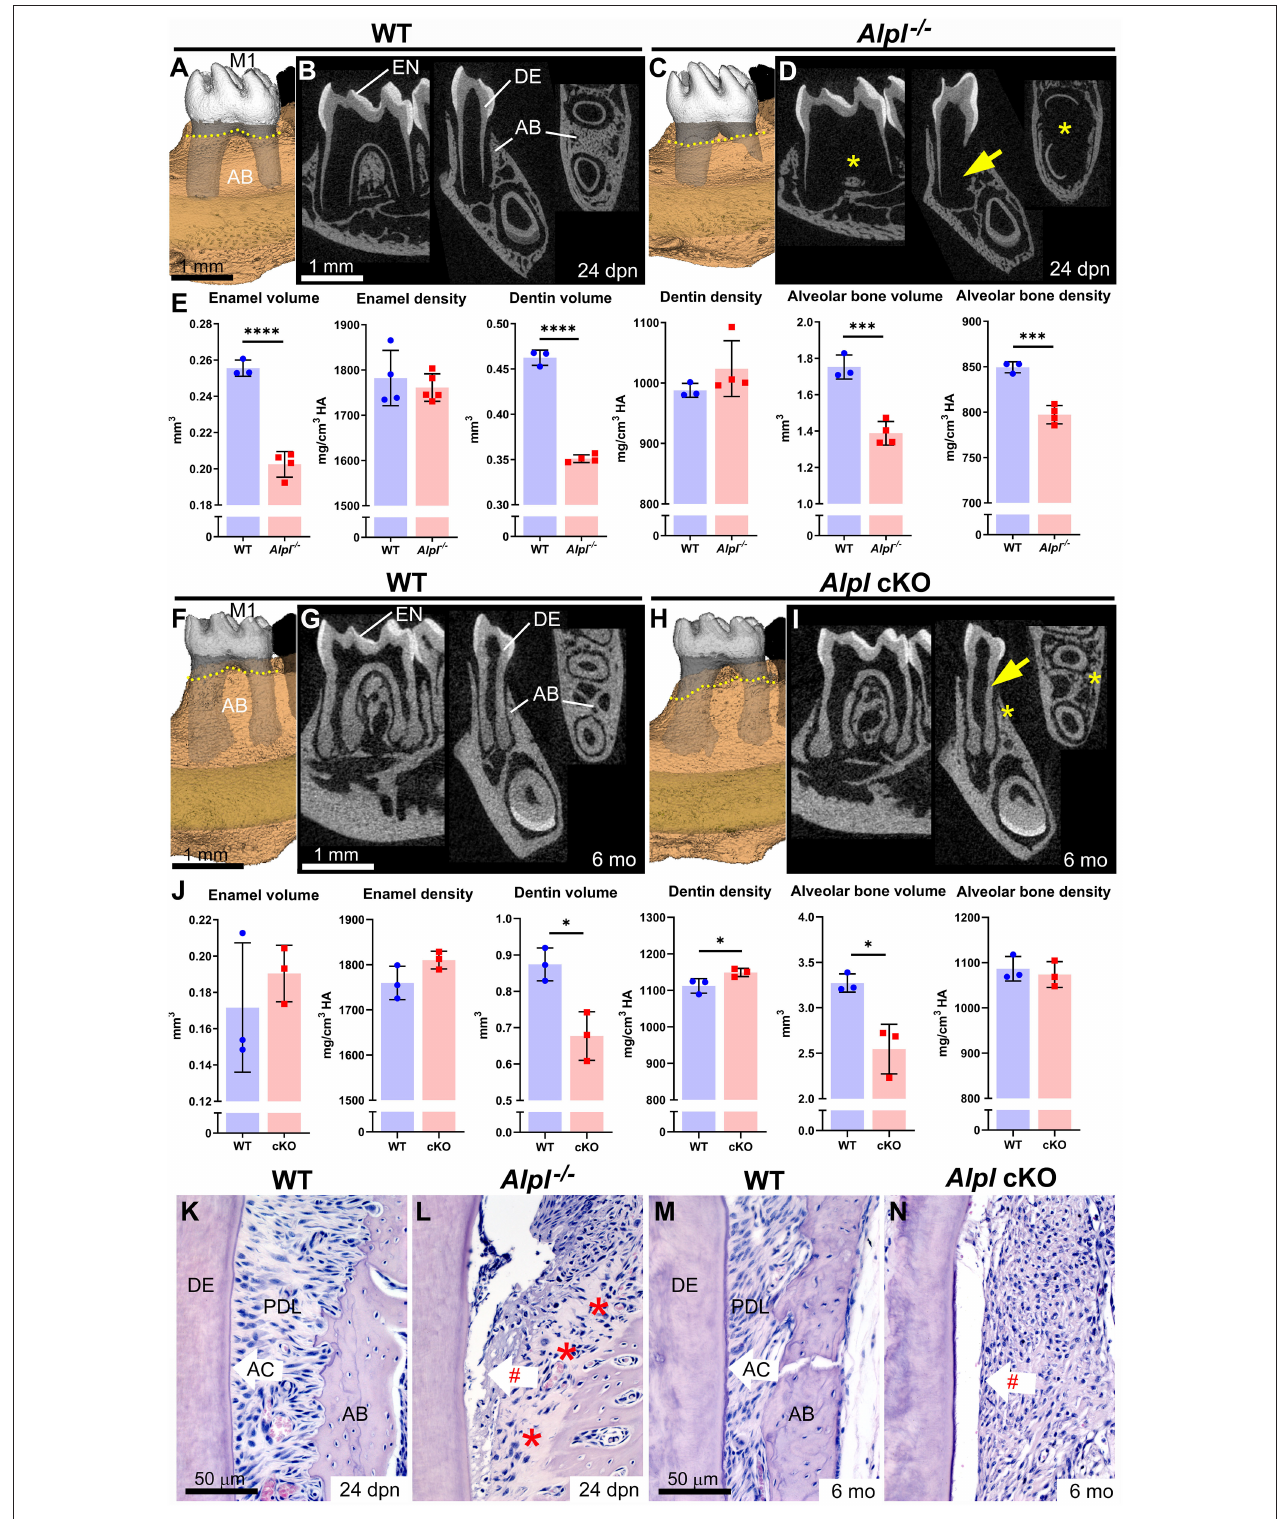
FIGURE 1 | Dentoalveolar defects in mouse models of hypophosphatasia. (A–D) 3D and 2D micro-CT renderings of first molars (M1) reveal severe dentin (DE) defects (yellow arrows) and alveolar bone (AB) defects (yellow *) in Alpl − / − vs. wild-type (WT) mice at 24 days postnatal (dpn). AB levels (yellow dotted lines in A and C) are already reduced in Alpl − / − vs. WT mice. (E) Compared to WT, Alpl − / − have reduced enamel (EN) volume, DE volume, and AB volume and density. (F–I) 3D and 2D